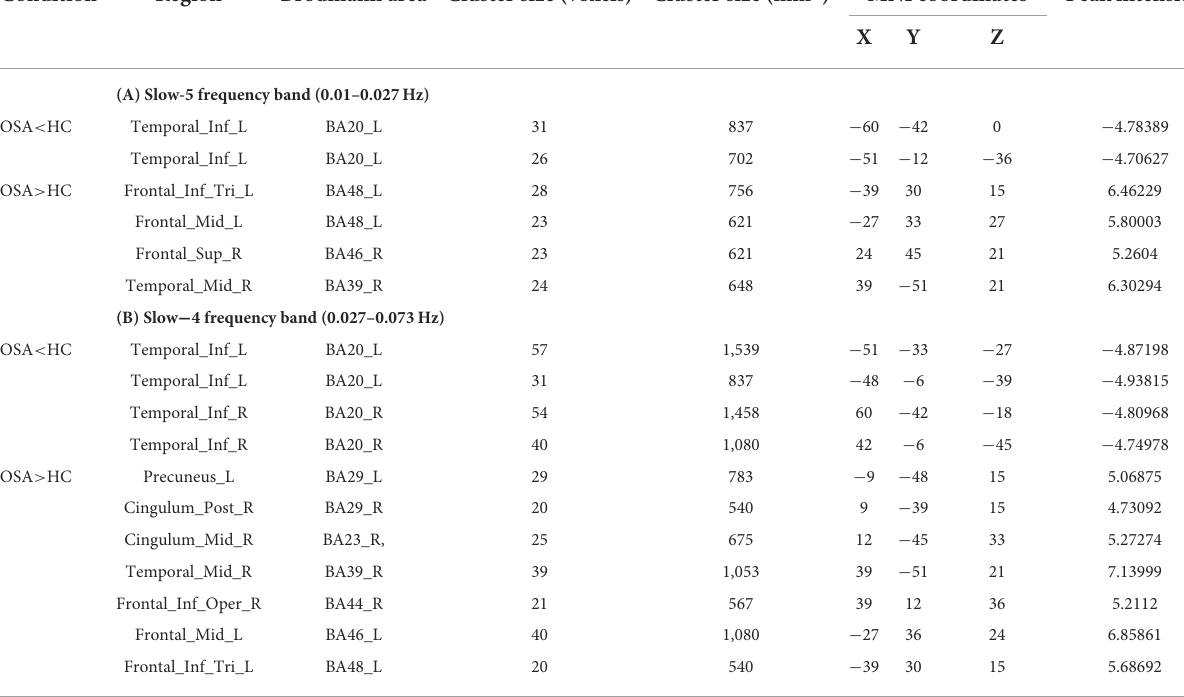
TABLE 2 The differences of ALFF in each frequency band between OSA groups and HC